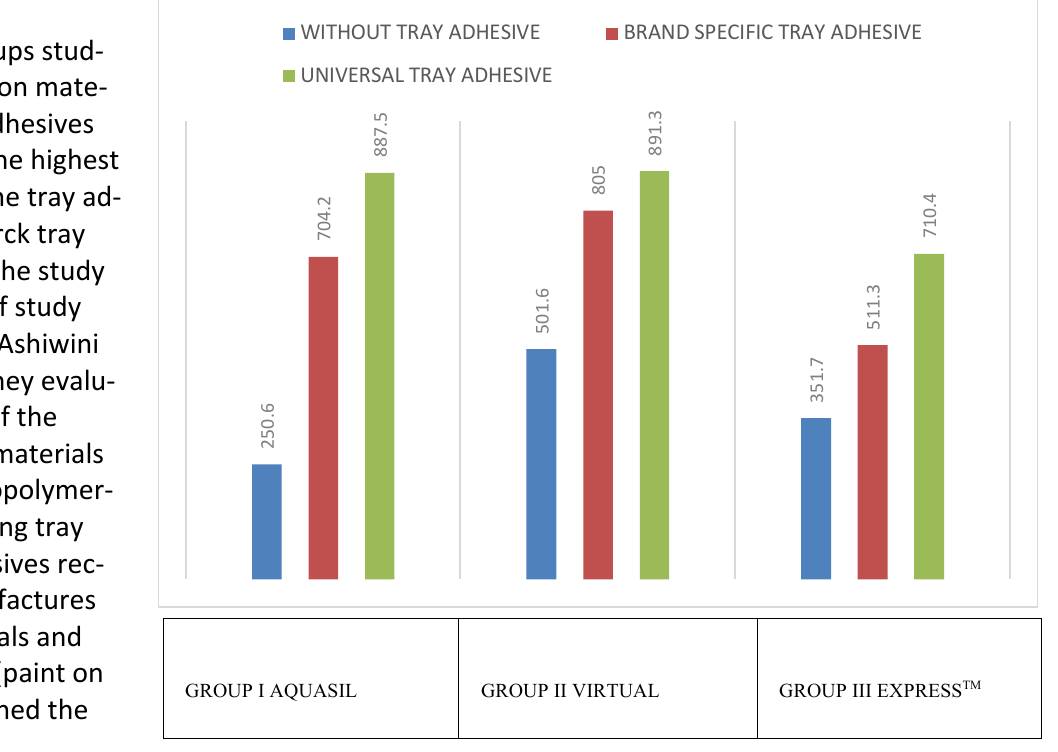
Graph 1. Bar diagram showing comparison of groups and